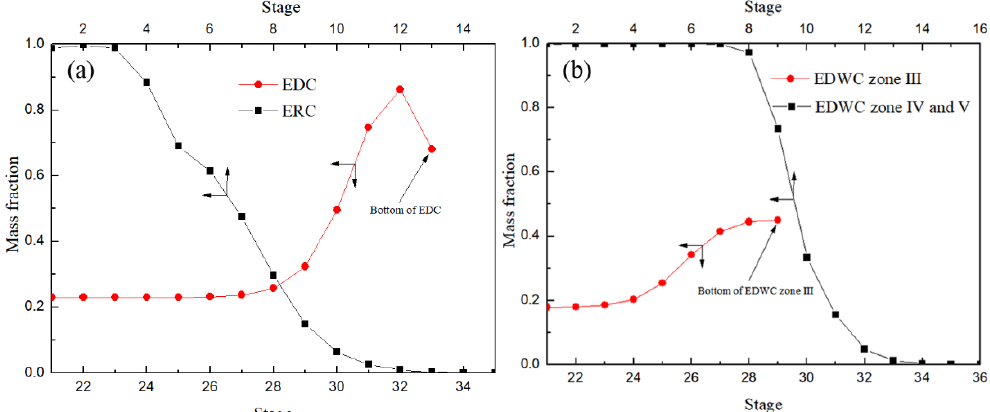
Figure 14. DMC liquid concentration profiles of CEP ( a ) and EDWC ( b ).